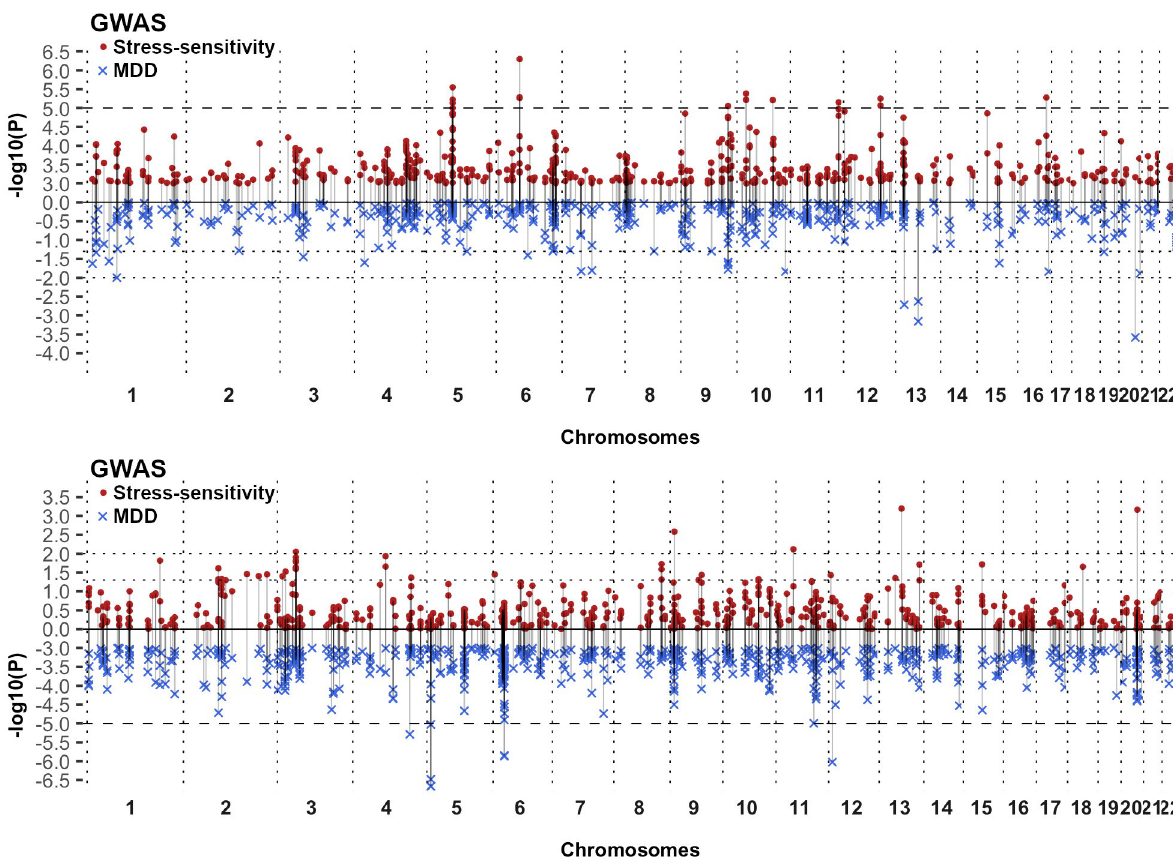
Fig 2. Miami plots showing comparison between association profile between stress-sensitivity GWIS and MDD GWAS. Miami plots from meta- analysis filter at p = 1x10 -3 : (A) filtering for stress-sensitivity p values (•), (B) filtering for MDD p values ( × ). The x-axis is chromosomal position and y-axis is the p value (-log10 p value) of association with stress-sensitivity (up; red dots) and MDD p value (down; blue crosses). Dot line: genome- wide suggestive threshold ( p = 1x10 -5 ) at the filtered effect; dashed lines: p = 0.01 and 0.05 at unfiltered